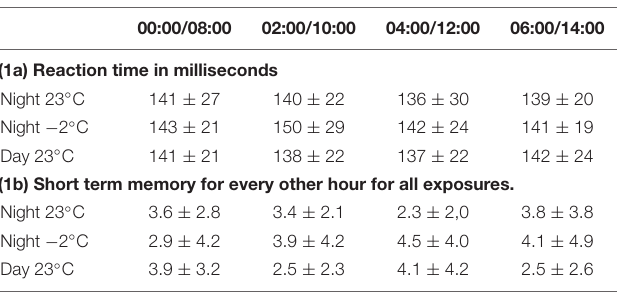
TABLE 1 | Cognitive parameters.